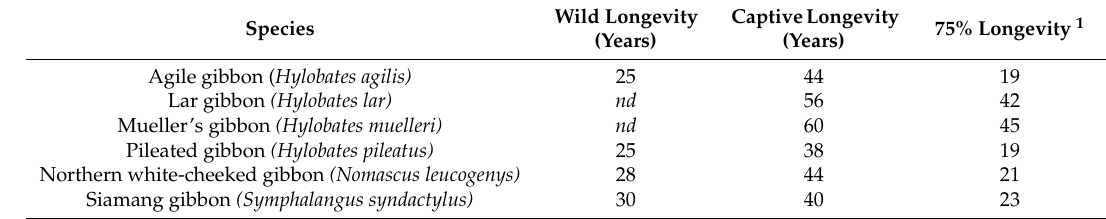
Table 1. Wild and captive life expectancy data used to calculate 75% longevity for elderly health check protocol currently implemented by this